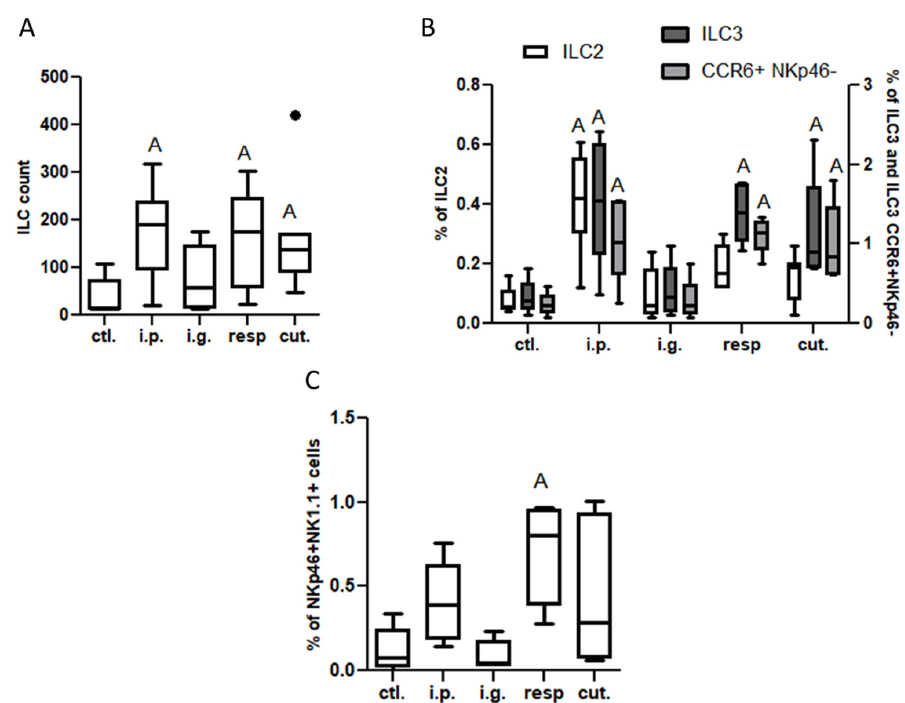
Figure 4. Innate lymphoid cells in lamina propria from mice exposed through the i.p., i.g., resp., or cut. routes compared to ctl. mice: ( A ) ILC count (CD45 + Lin − CD4 − CD127 + cells); ( B ) ILC2 (ST2 + NK1.1 − cells within ILC, empty bars), ILC3 (ST2 − NK1.1 − cells selected within ILC; dark gray bars), and CCR6 + NKp46 − ILC3 (light gray bars) frequencies; and ( C ) NK cells (NK1.1 + NKp46 + cells selected within CD45 + lin − , then CD4 − CD127 − cells). All frequencies are expressed using CD45 + cells as a reference. “A” indicates a significant difference between indicated group and control mice ( p < 0.05 using non-parametric Kruskal–Wallis and Dunn’ post-Test). The bold black dot represents an